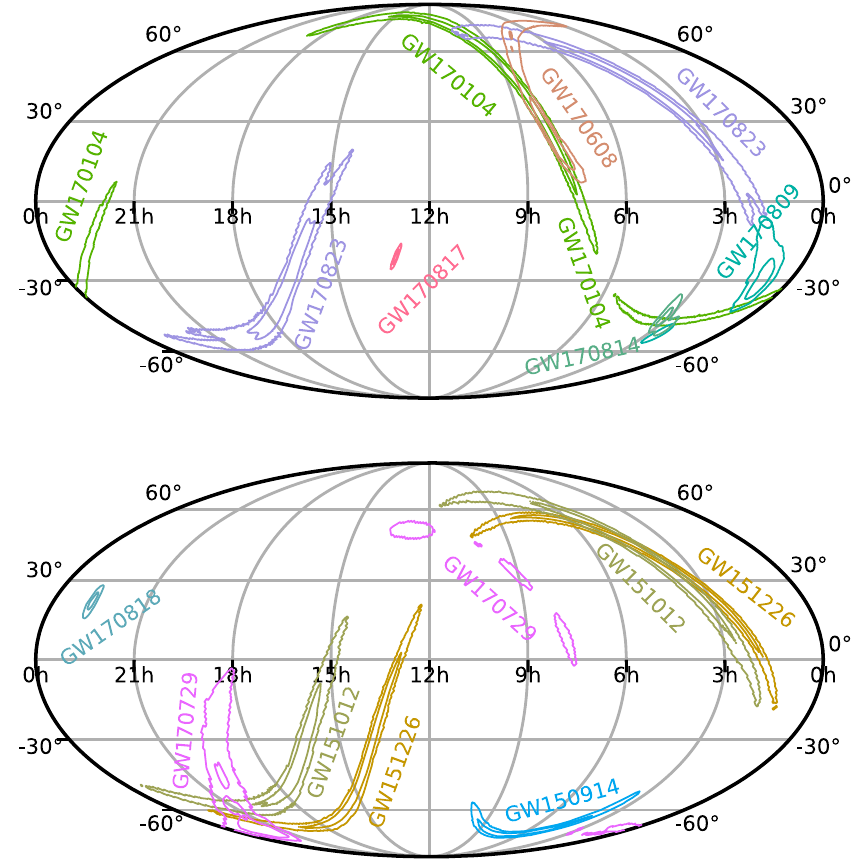
FIG. 8. Parameter estimationsummary plots V. The contours show 90% and 50% credible regionsfor the sky locations of all GWevents in a Mollweide projection. The probable position of the source is shown in equatorial coordinates (right ascension is measured in hours, and declination is measured in degrees). 50% and 90% credible regions of posterior probability sky areas for the GW events. Top: Confidently detected O 2 GWevents [22] (GW170817, GW170104, GW170823, GW170608, GW170809, and GW170814) for which alerts were sent to EM observers. Bottom: O 1 events (GW150914, GW151226, and GW151012), along with O 2 events (GW170729 and GW170818) not